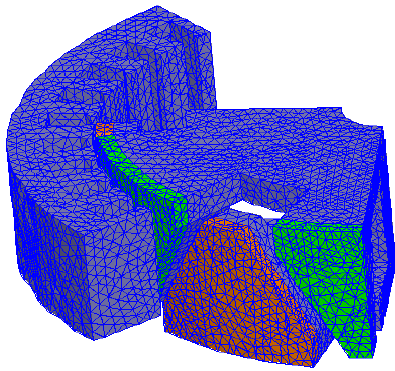
Figure 2. Mesh plot model of the core.